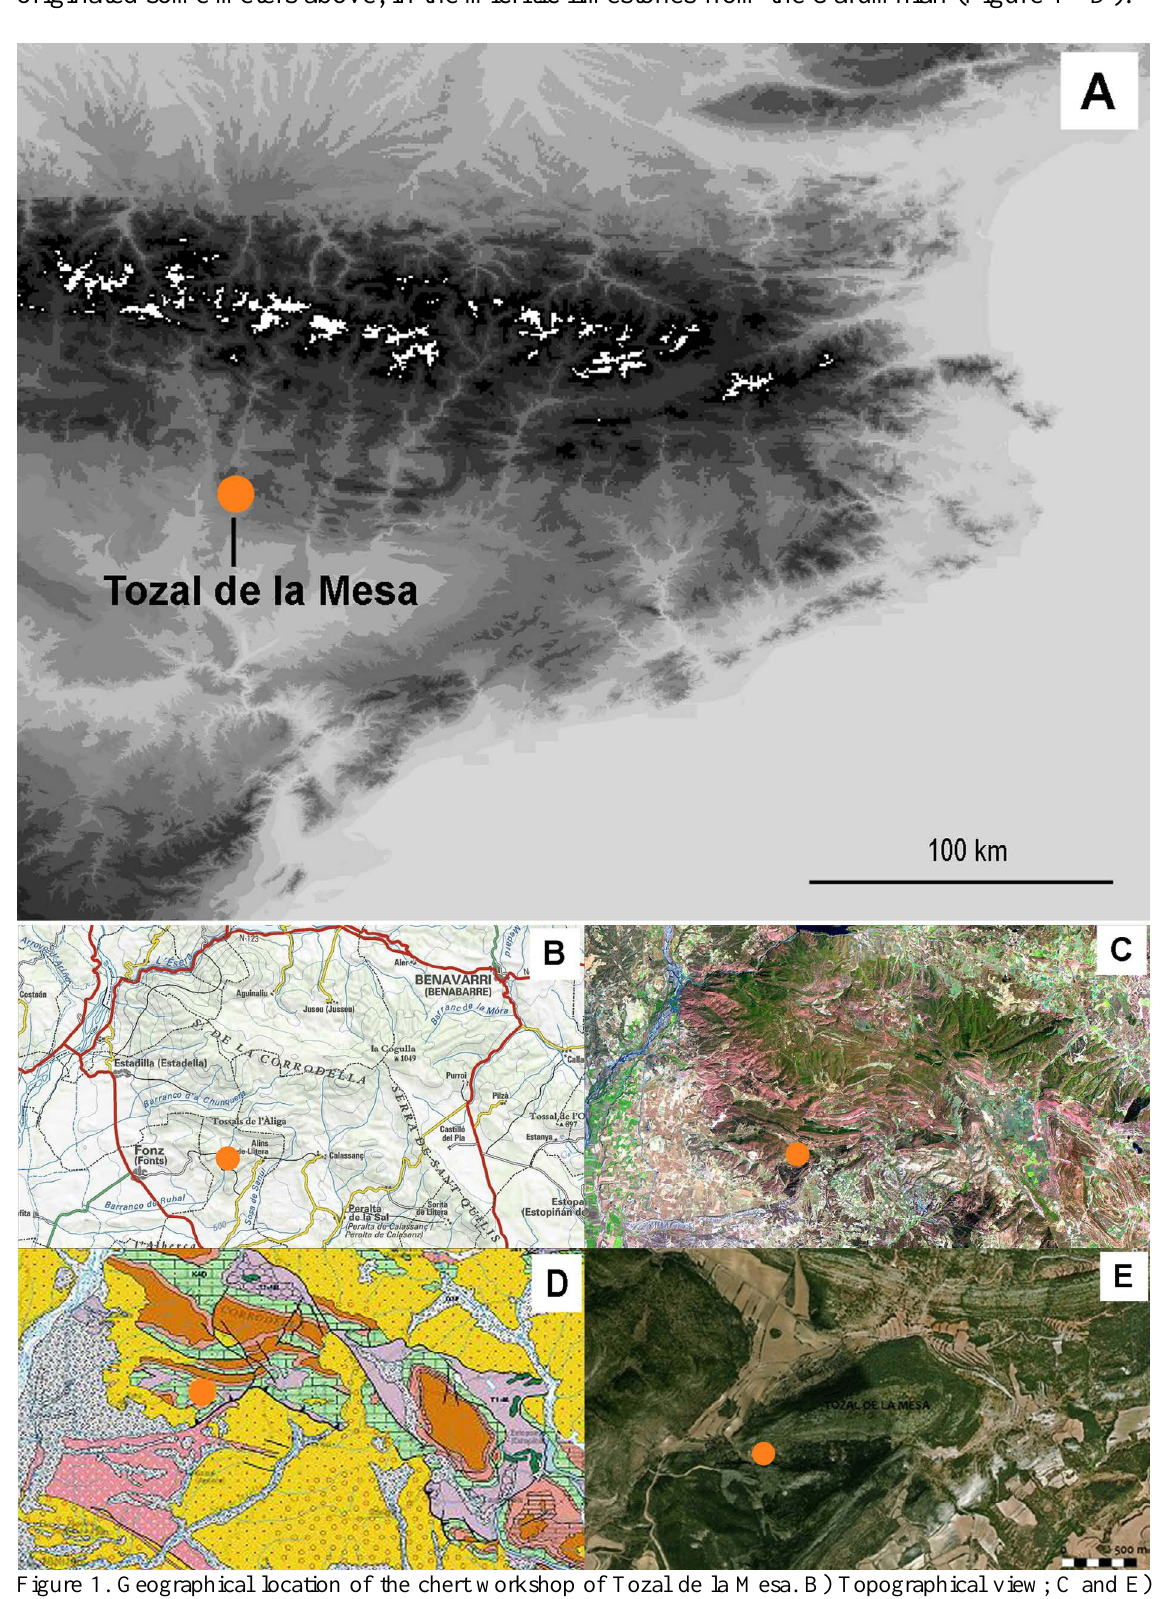
Figure 1. Geographical location of the chert workshop of Tozal de la Mesa. B) Topographical view; C and E) Geomorphological view; D) Geological